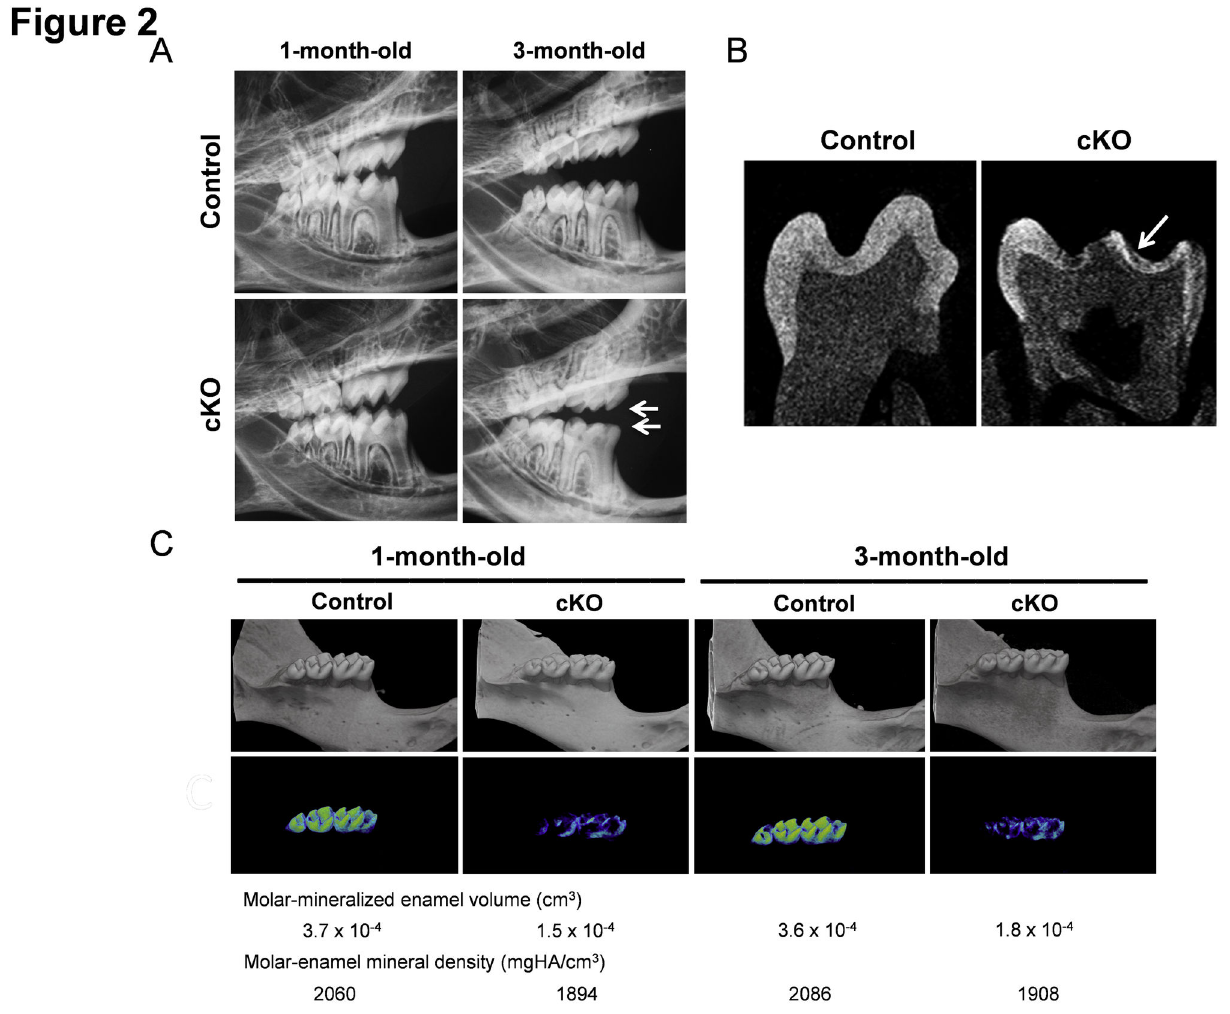
Figure 2. Enamel attrition in the cKO teeth. (A) Radiographs of 1- and 3-month-old mouse teeth. 3-month-old mandibular and maxilla of a cKO mouse shows enamel attrition along the molar cusps (white arrows). (B) µCT images of a single slice view of the molar showing thinner enamel along the molar cusps in a cKO mouse (white arrow). (C) Quantitative µCT analysis of the mandibular molars shows more than two fold decrease in molar mineral enamel volume and a slight decrease in molar enamel density in cKO mice in both 1 and 3 month old